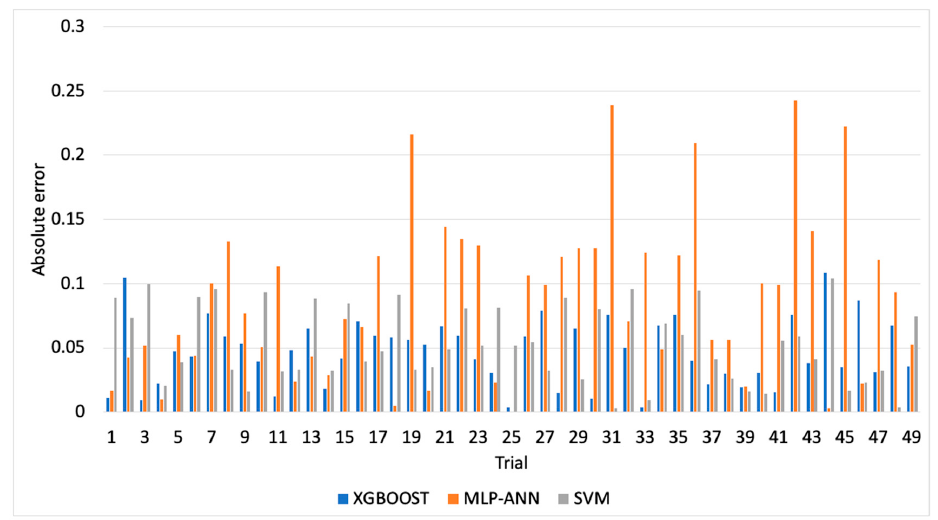
Figure 4. Comparison of errors in prediction of flank wear in for a copper workpiece.